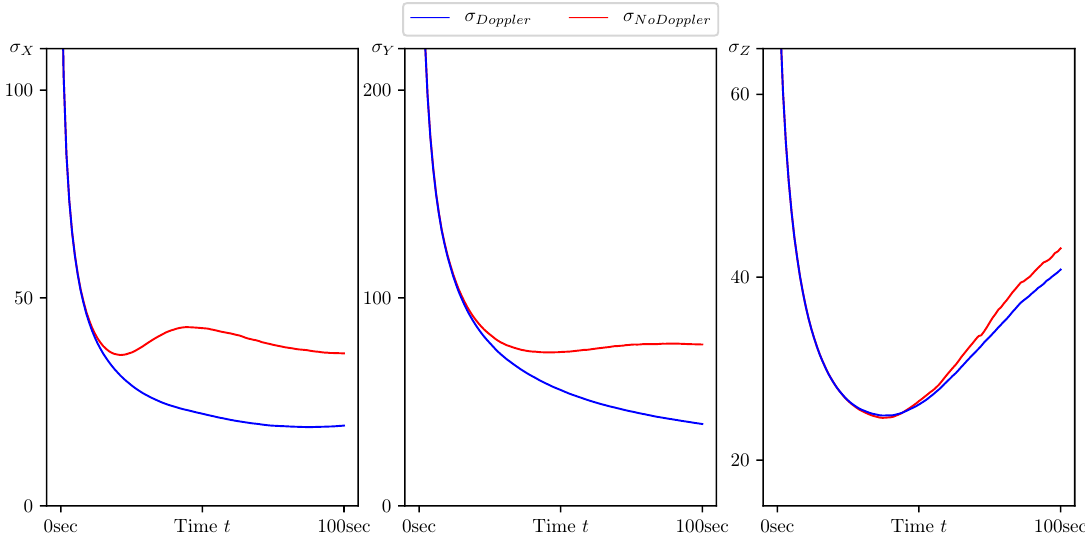
Figure 5. Standard deviation of estimation error for the coordinates ( X t , Y t , Z t ) calculated by CMNF filter with and without Doppler measurements.